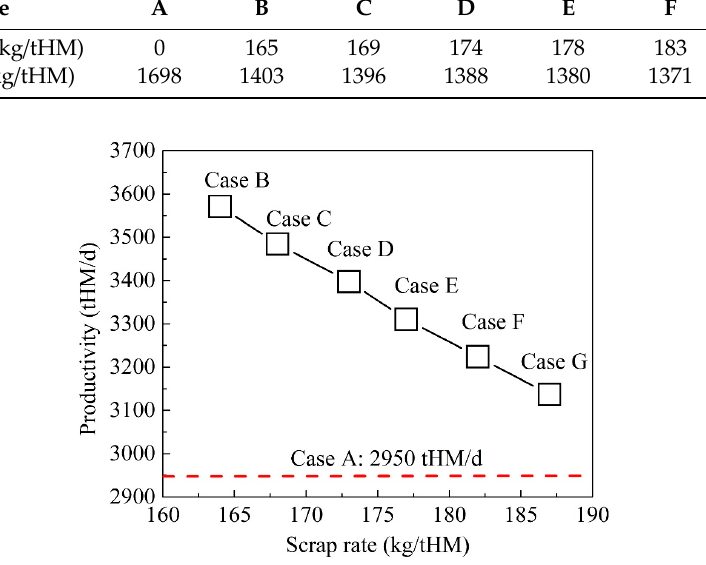
Figure 5. Change in BF productivity with scrap rate.